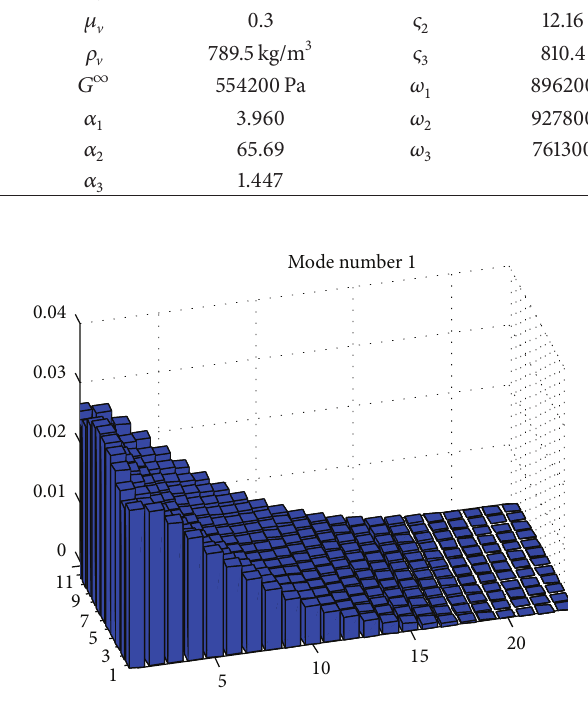
Figure 4: The modal strain energy of the first